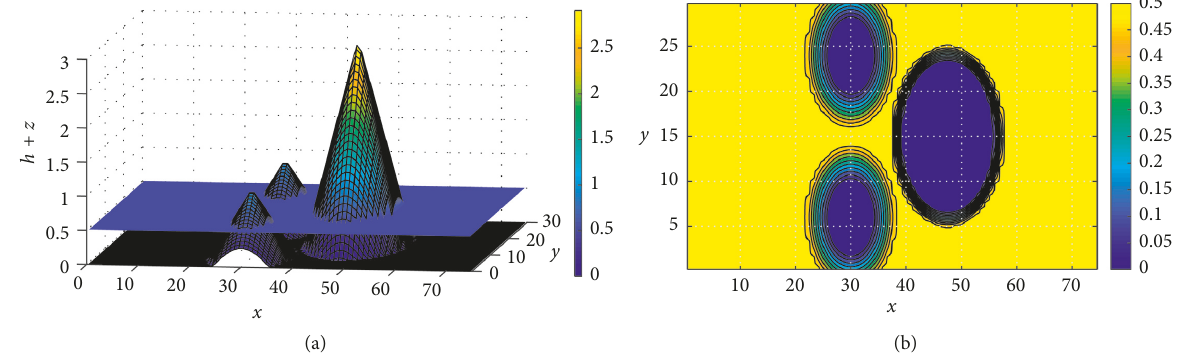
Figure 16: The water surface profile (a) and its contour plot (b) of a dam-break flow over three humps at t � 5000s using 85 × 85 uniform grid cells.